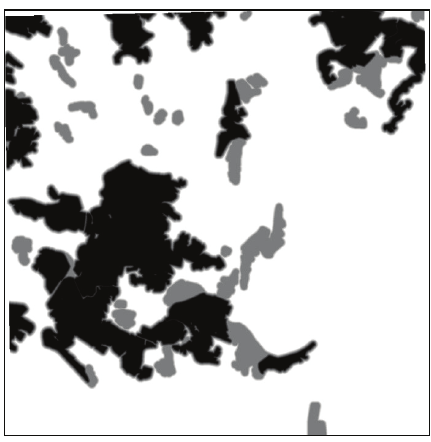
Figure 5: Visualization of calculation results of coefficient 𝐶 3 .